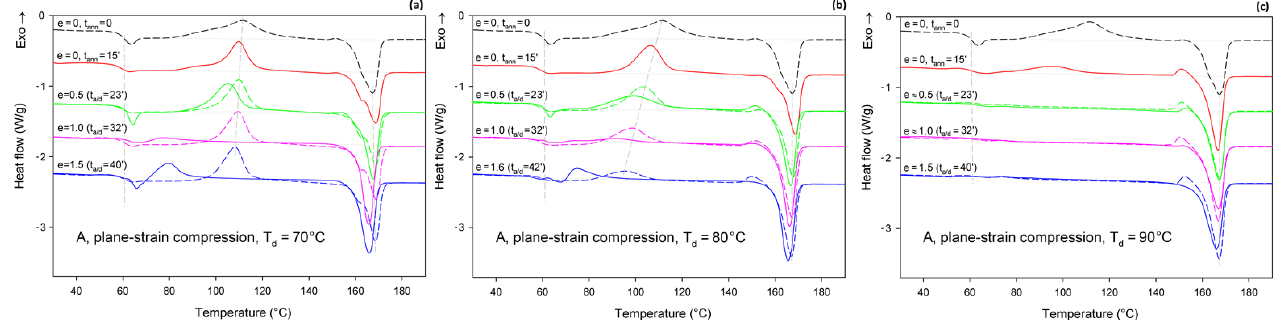
Figure 7. DSC heating scans of initially amorphous samples (A) deformed in plane-strain compression at T d = 70 °C ( a ); 80 °C ( b ); and 90 °C ( c ), to the indicated true strain (solid lines). For each sample before deformation, a soak time of 15 min was used to equilibrate the temperature. The dashed lines represent samples that were annealed only at the respective temperature and time but were not deformed. The total residence time at the deformation or annealing temperature, t a/d , is indicated for each curve.